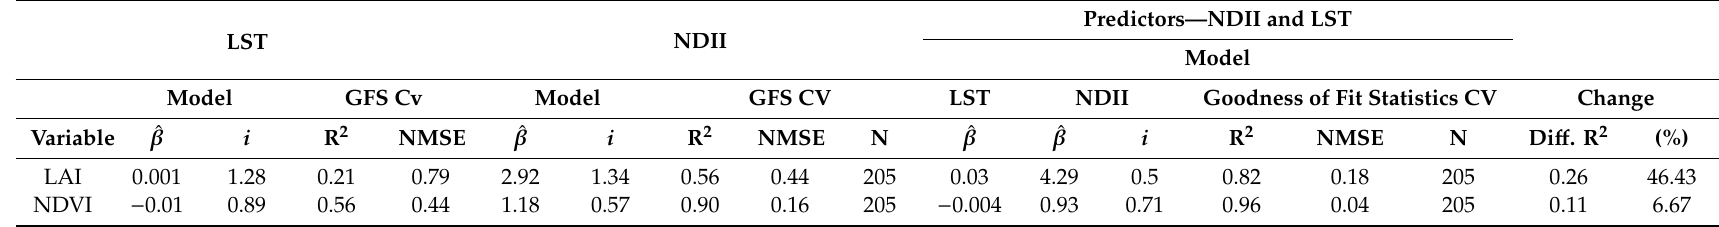
Table 5. CCR.LM coe ffi cients of estimates and goodness of fit statistics (at 95% confidence level) during the dry season with NDII and LST as predictors. Accounting for variations in LAI was improved by about 46% when LST and NDII were simultaneously used as predictor